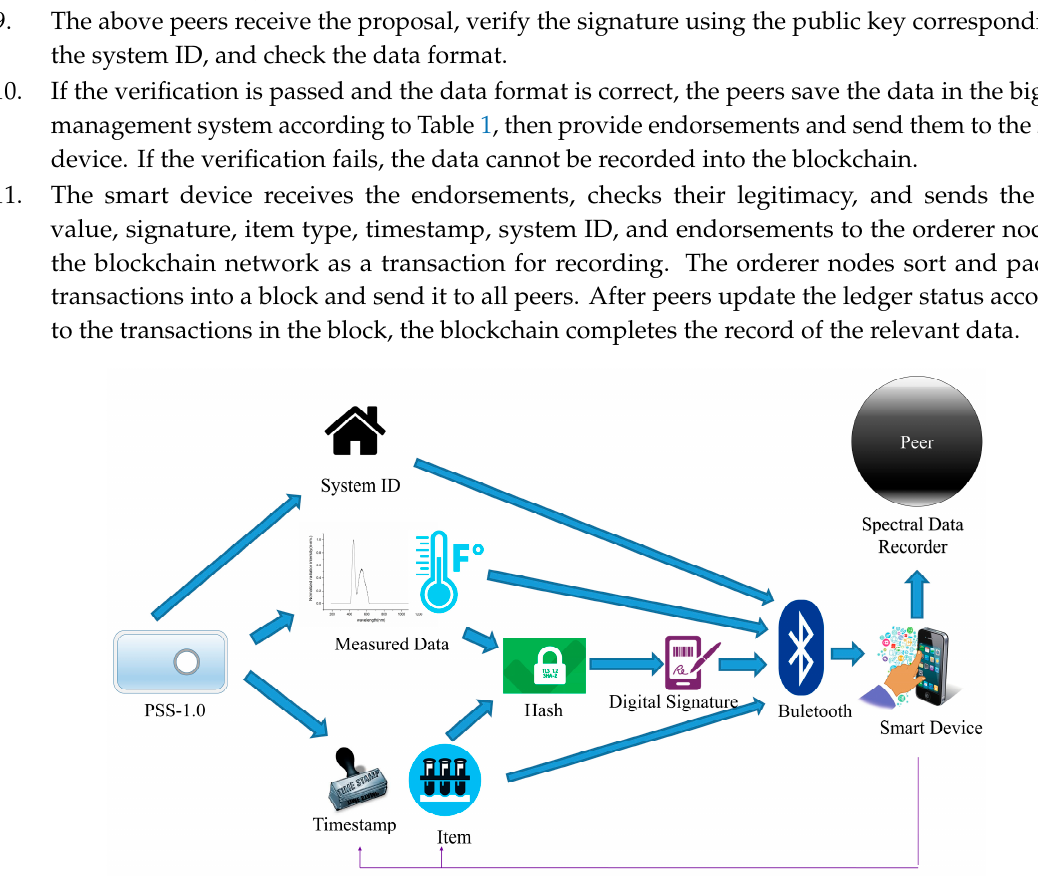
Figure 10. Method of portable smart spectrometer processing measured data.